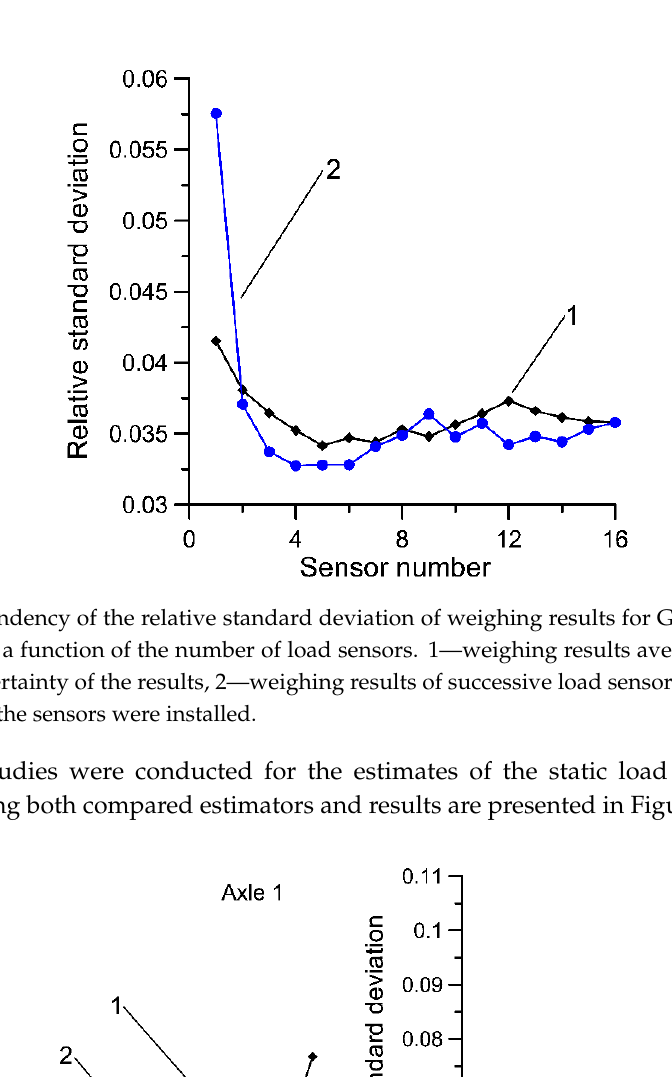
Figure 7. Relative standard deviation of estimates of static axle load, ( a )—axle no. 1; ( b )—axle no. 5; with results averaged in order of increasing uncertainty of the results. Curve 1—results for Equation (1), curve 2—results for Equation (7).